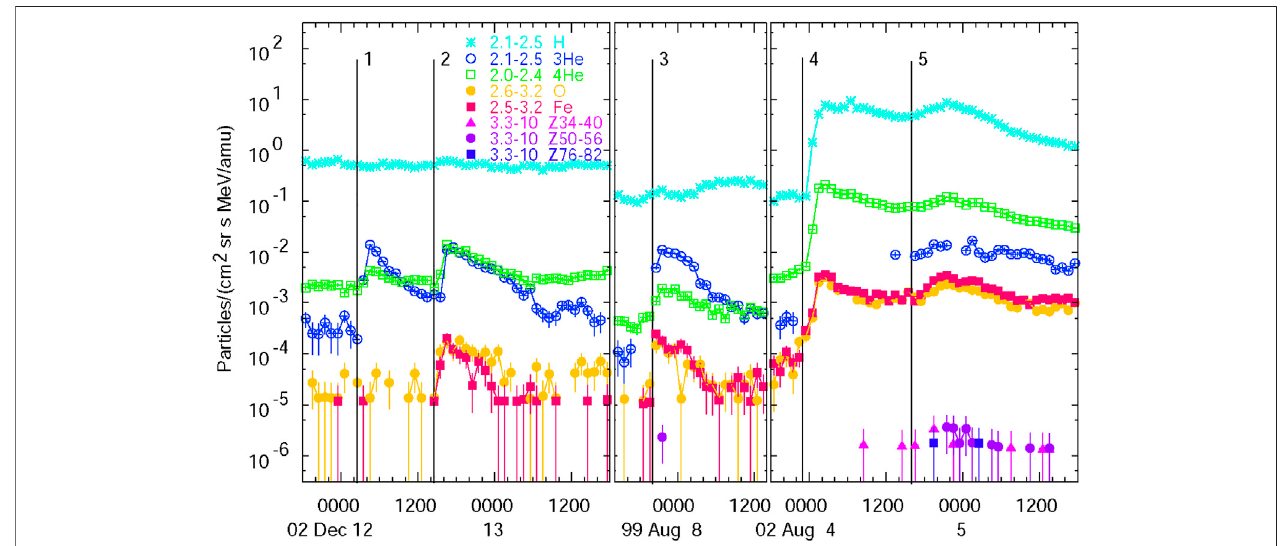
FIGURE 1 | Ion intensities at the indicated MeV amu − 1 are shown in a sample of 3 He-rich or “ impulsive ” SEP events of increasing intensity. 3 He exceeds 4 He in Events 1 and 3. Fe and O are below background in Event 1, but Fe/O ≈ 1 in the remaining events. H is below background in Events 1 – 3. 3 He/ 4 He < 0.1 in Event 4 and is omitted because of possible resolution errors; it is ≈ 0.1 in Event 5 and high- Z heavy elements are beginning to appear (Reames and Ng, 2004). Other properties of the last four of these events are listed in Reames et al.